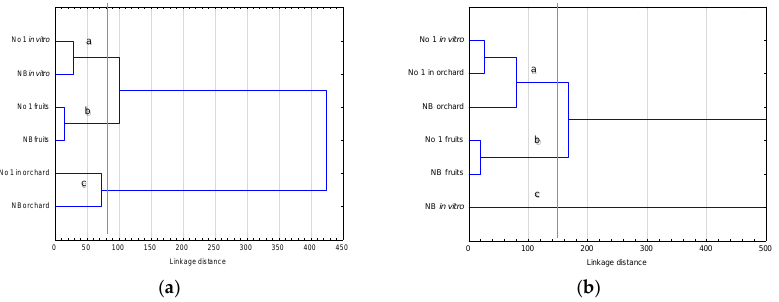
Figure 1. Dendrogram of cluster analysis of micro- and microelements ( a ) and polyphenols ( b ) in two cultivars of goji fruit and leaves (cut off—85 and 150).